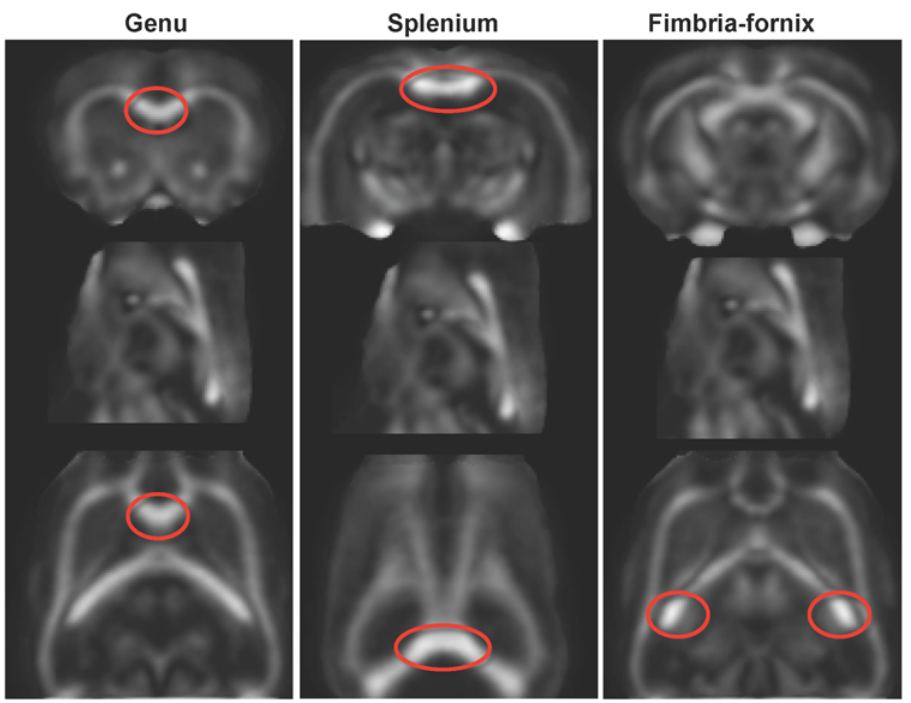
Fig 2. FA maps with circles indicating regions of the genu (right) and splenium (middle) of the corpus callosum and fimbria-fornix (left) used for fiber tract quantification of FA and MD.